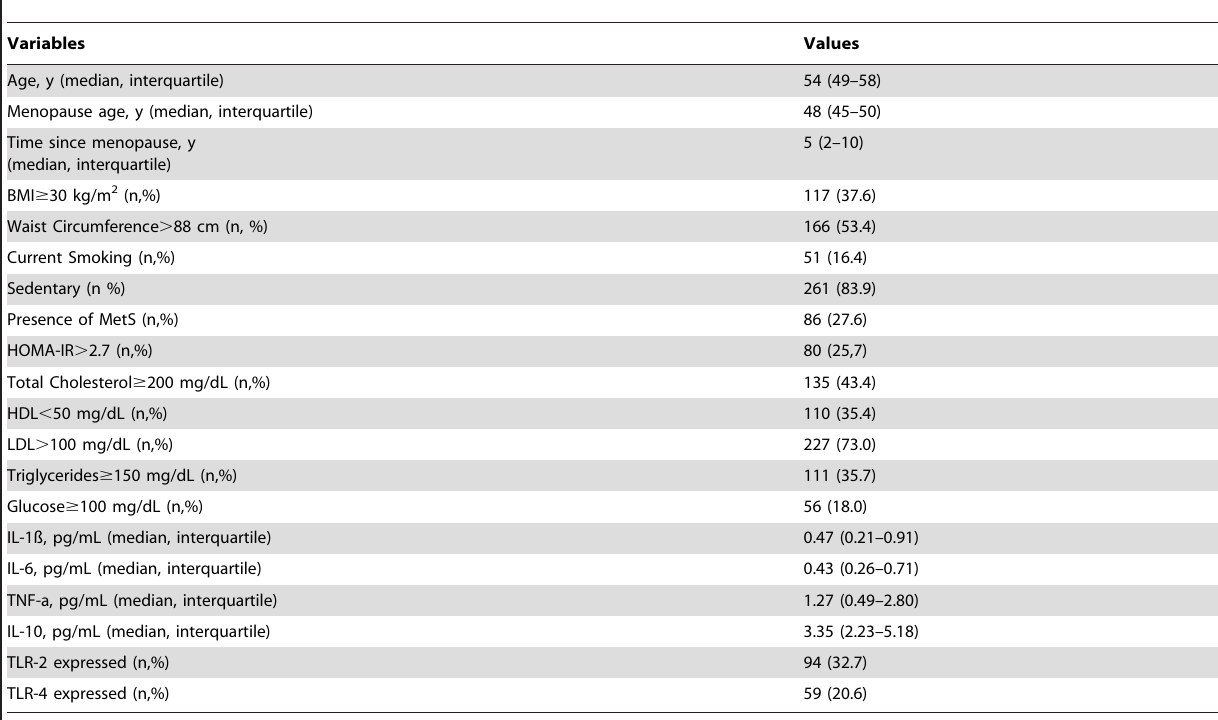
Table 2. Descriptive characteristics of 311 postmenopausal women.